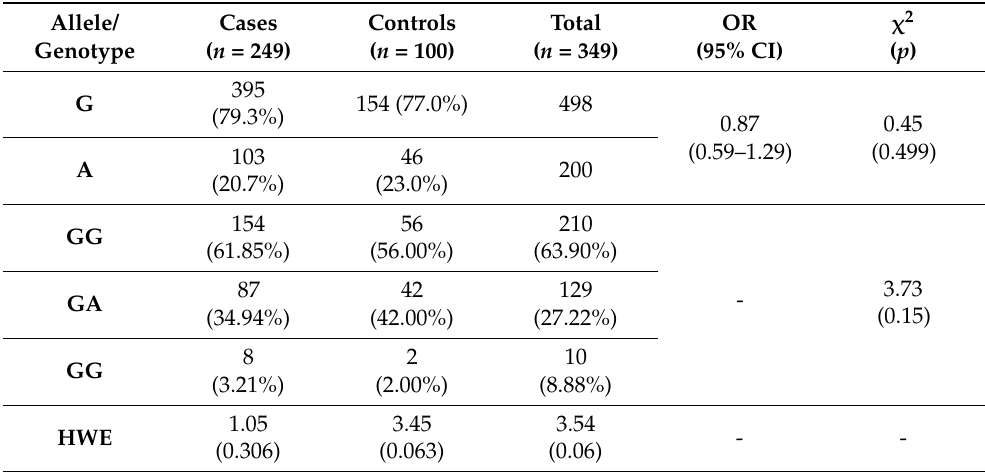
Table 1. Allele frequency, genotype distribution and Hardy–Weinberg equilibrium of IRS-1 Gly972Arg polymorphism in PCOS as compared with control women.